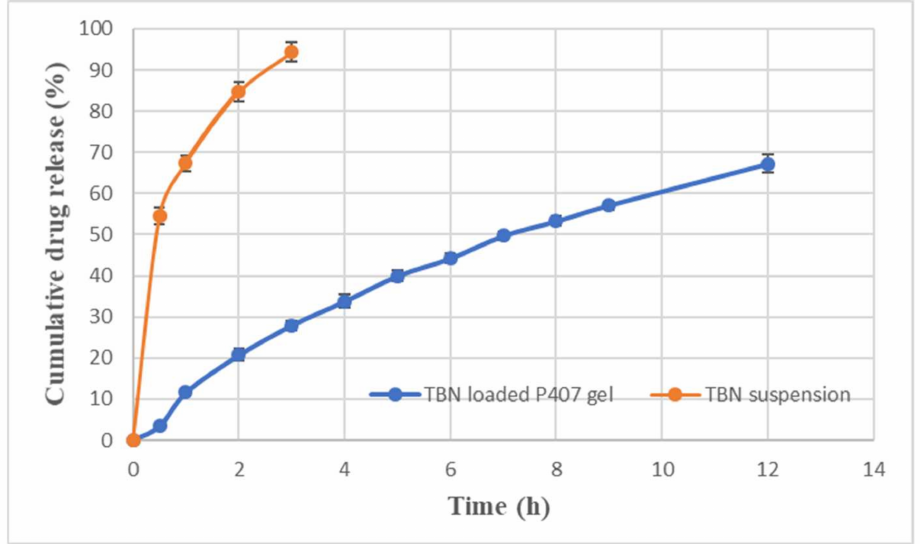
Figure 8. Comparison of in vitro release of terbinafine from optimized P407 gel formulation and TBN suspension.